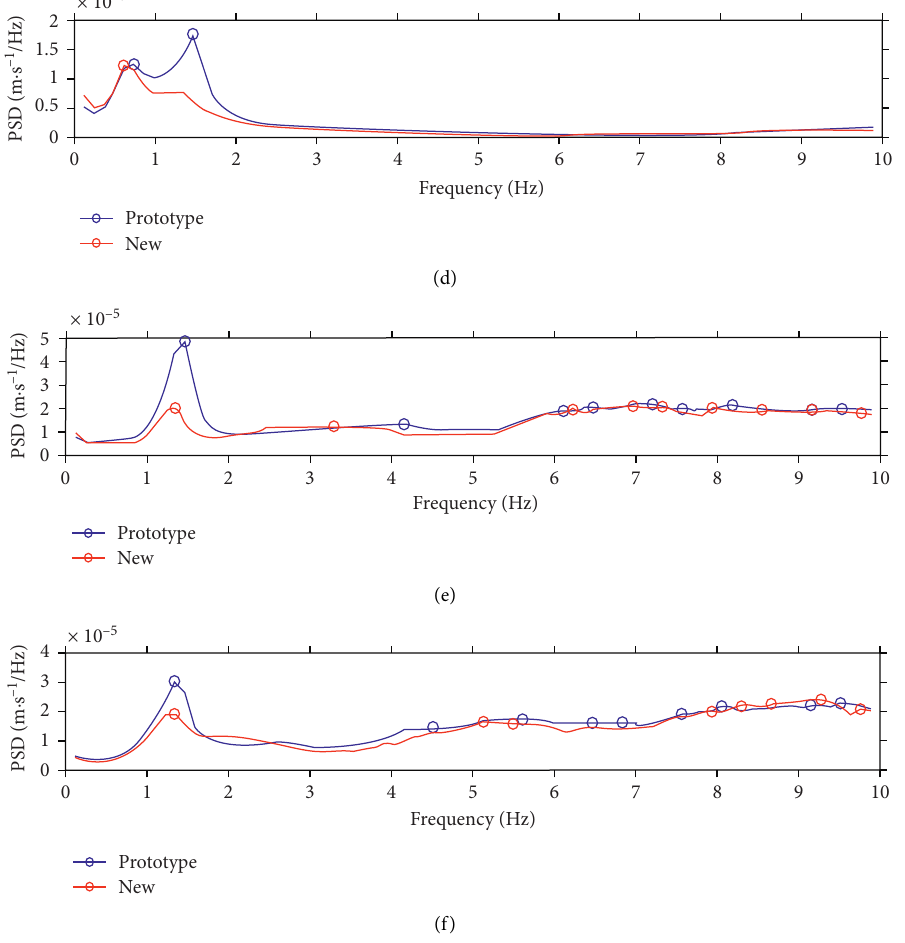
Figure 18: Response of vehicle lateral vibration. (a) Lateral translation of the vehicle body. (b) Yaw of the vehicle body. (c) Rolling of the vehicle body. (d) Lateral translation of the bogie frames. (e) In-phase yaw of the bogie frames. (f) Antiphase yaw of the bogie